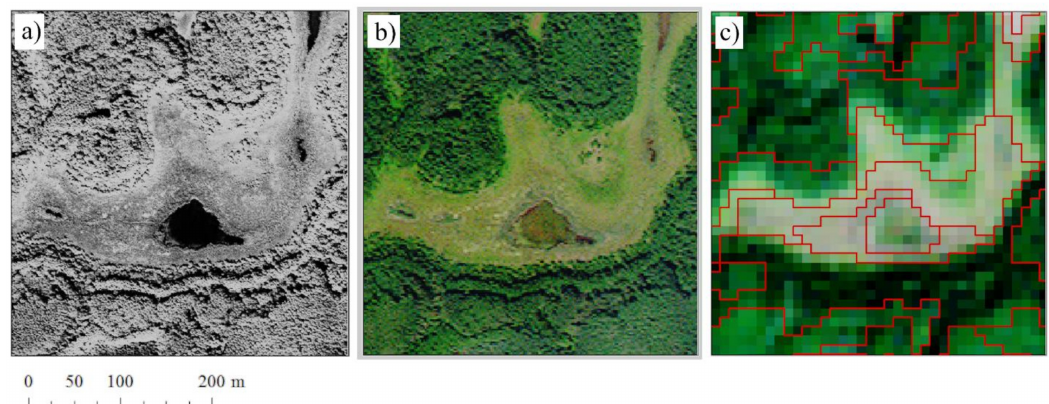
Figure 1. ( a ) Optical Worldview-2 panchromatic band (0.3 m pixel resolution) for a bog / shallow open water wetland in central Alberta, Canada. Identifiable shrubs along the transition zone between the wetland and riparian zone are visually observed in the images; ( b ) visible colour composite from Worldview-2 for the same bog. Pixel resolution is 1.4 m, smaller shrubs are within pixels and are averaged, making the boundary between shrubs and riparian area easier to discern; ( c ) Sentinel-2 data (visible colour composite) where transition zone is integrated with riparian and forest and wetland edge can be identified. Red outlines represent object-oriented segmentation associated with spectral reflectance di ff erences of vegetation and soil moisture, riparian and forested